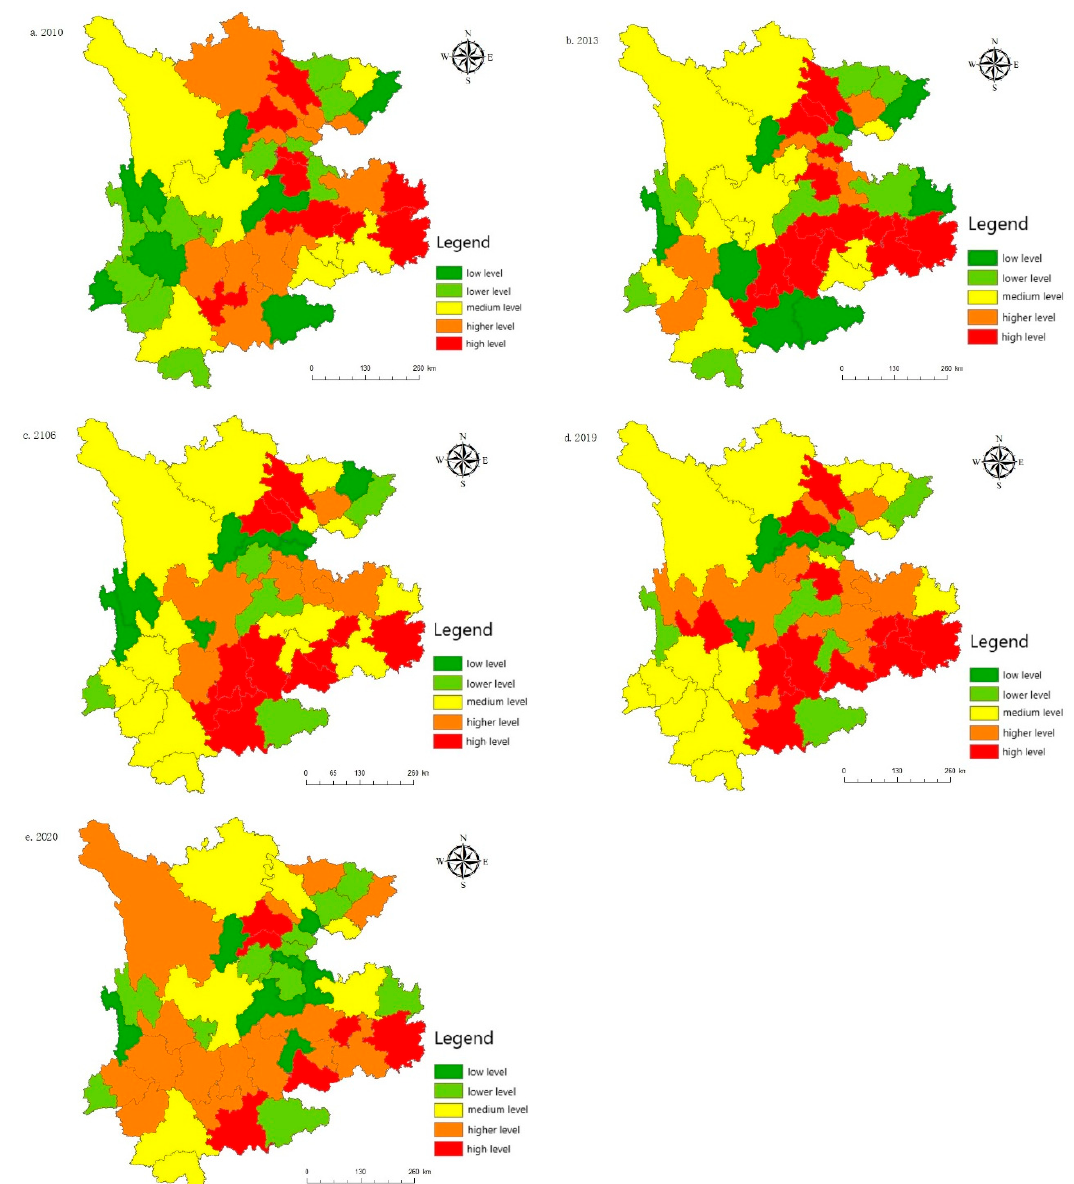
Figure 6. Spatial distribution of the urbanization development level: ( a ) The urbanization develop- ment level in 2010; ( b ) The urbanization development level in 2013; ( c ) The urbanization develop- ment level in 2016; ( d ) The urbanization development level in 2019; ( e ) The urbanization develop- ment level in 2020.